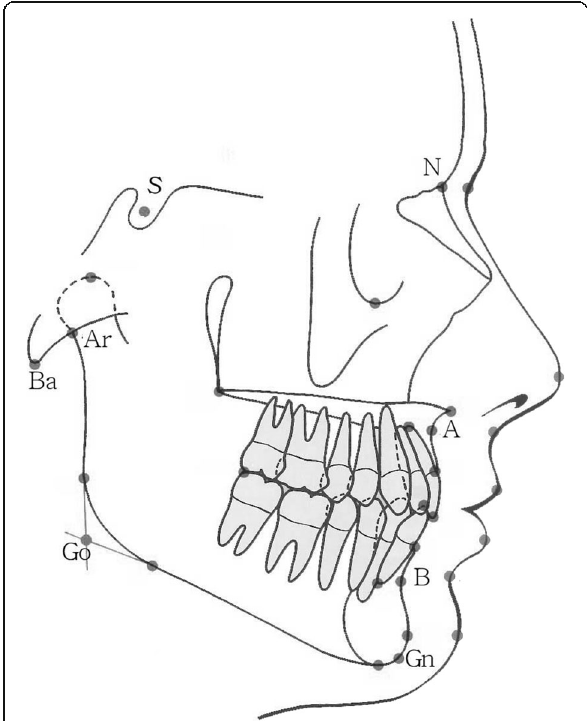
Fig. 2 Common landmarks and reference lines used for linear and angular measurements in the lateral